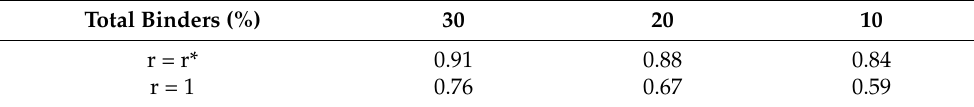
Table 8. Strength